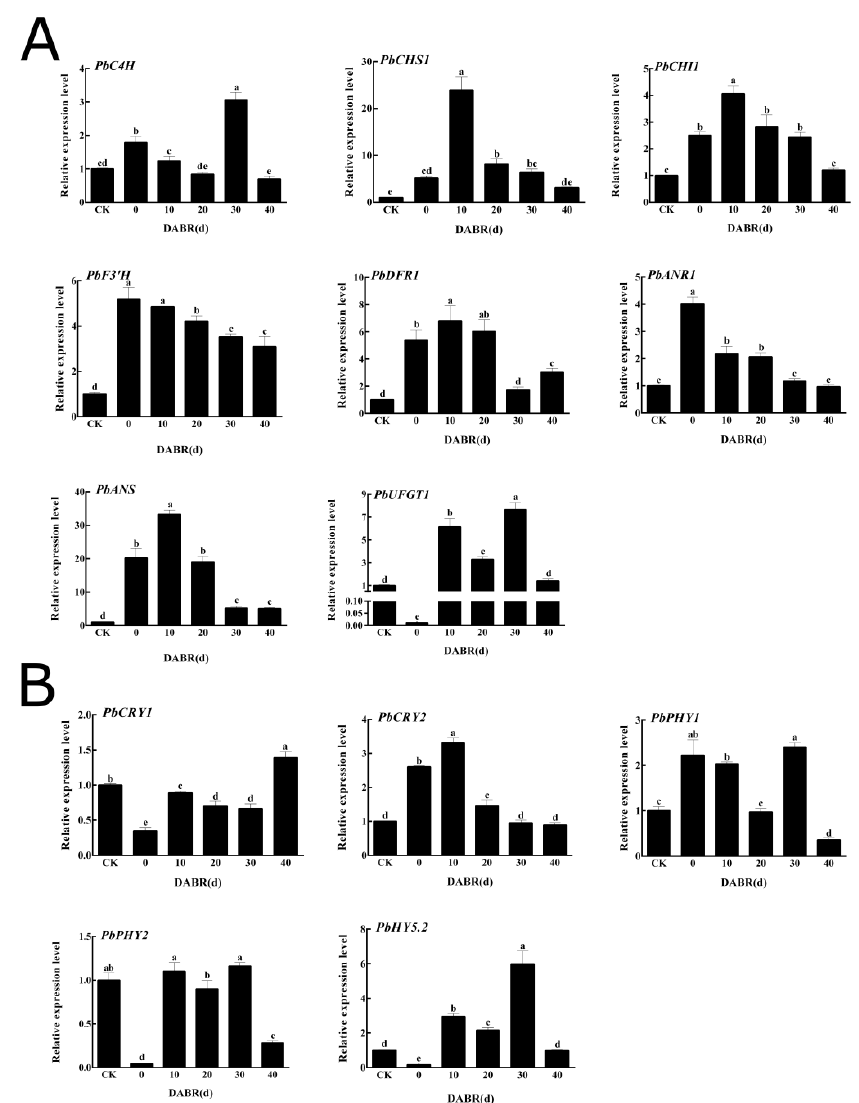
Figure 4. Relative expression levels of genes associated with light response and anthocyanin synthesis in the skin of ‘Xinqihong’ pear fruit after bag removal: ( A ) Expression levels of anthocyanin-synthesis-related genes. ( B ) Expression levels of light-response-related genes. DABR: days after bag removal. Different letters indicate significant